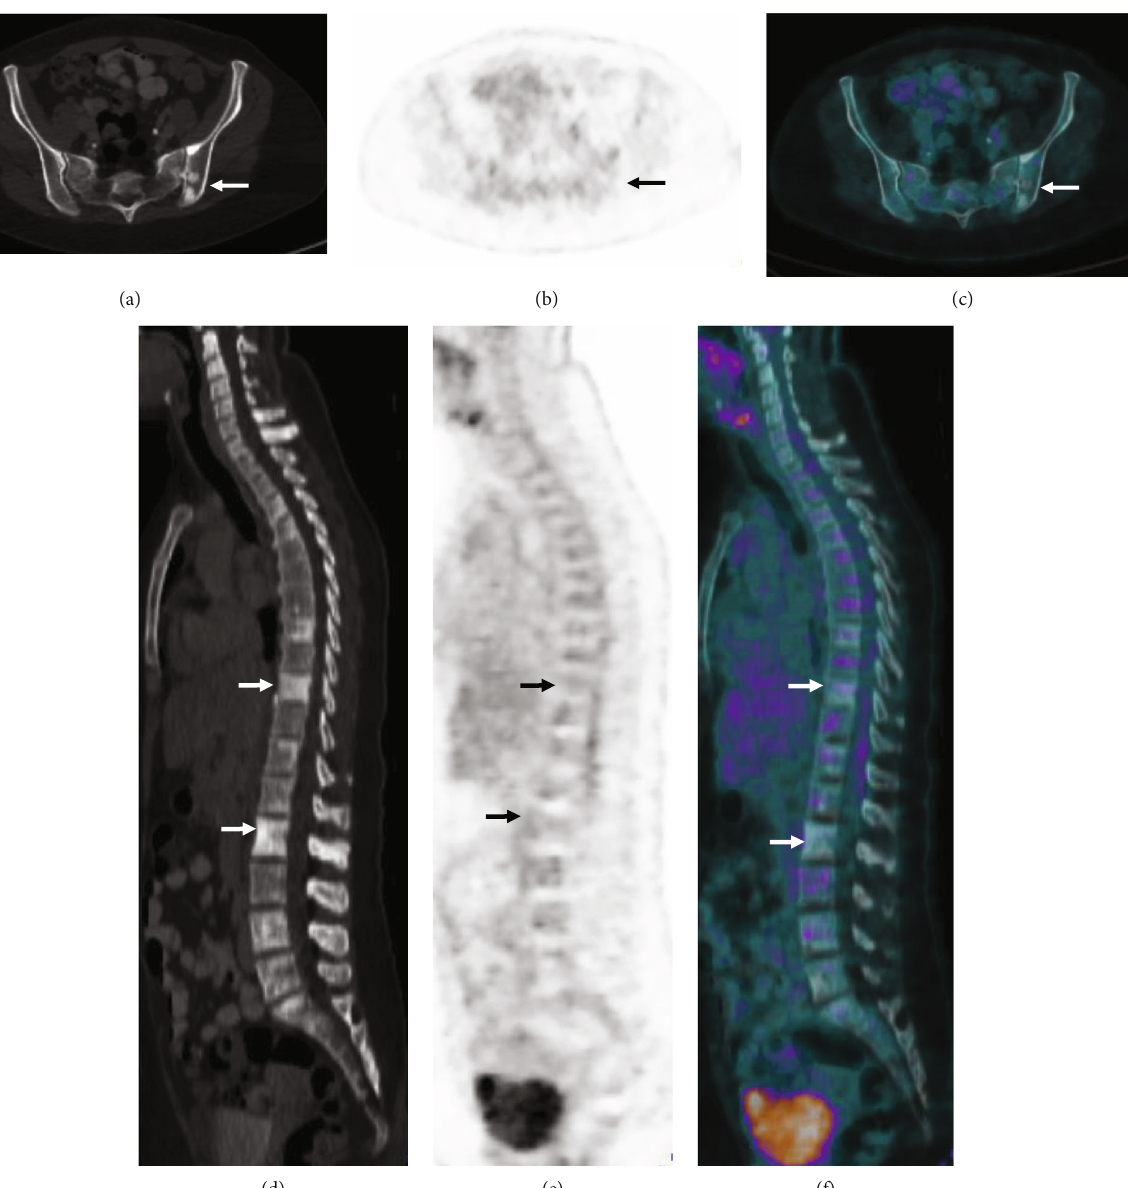
Figure 2: Axial low dose CT (a), FDG PET (b), and fused FDG PET/CT (c) images demonstrate sclerotic bone lesions in the bony pelvis with no signi fi cant FDG uptake (arrows). Sagittal CT (d), FDG PET (e), and fused FDG PET/CT (f) images demonstrate sclerotic bone lesions throughout the spine with no signi fi cant FDG uptake